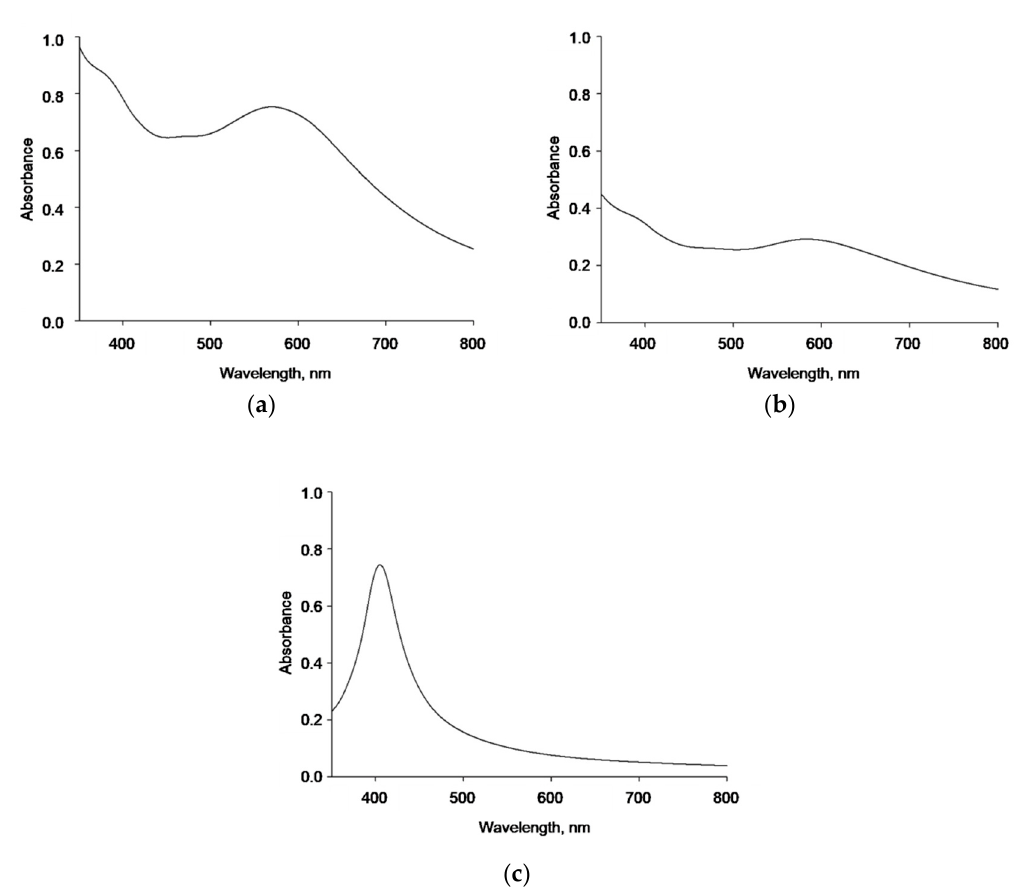
Figure 3. Spectrophotometric analysis of AgNPs in 0.2 M sodium-phosphate bu ff er (pH = 6.8). ( a ) Absorbance spectrum of 83.41 µ g / mL naked AgNPs; ( b ) absorbance spectrum of 22.59 µ g / mL AgNP-TBA nanoparticles; ( c ) absorbance spectrum of 7.66 µ g / mL AgNP-MUA